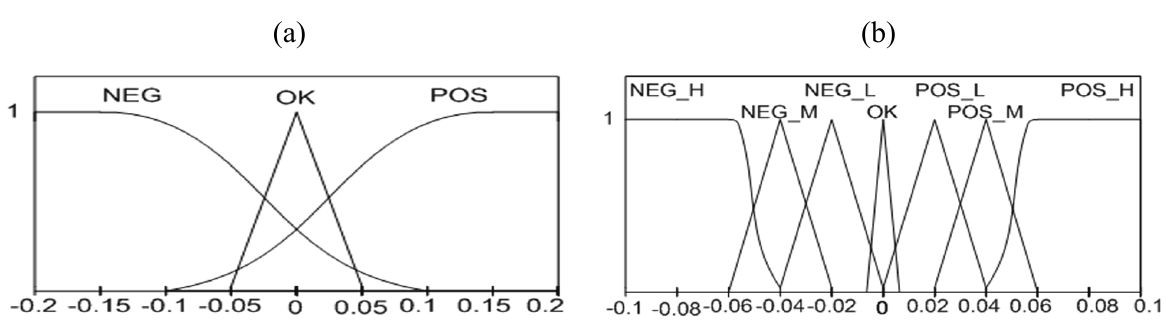
Figure 8. (a) Membership functions of the input signal of Fc3a. (b) Membership functions of the output signal of Fc3a.